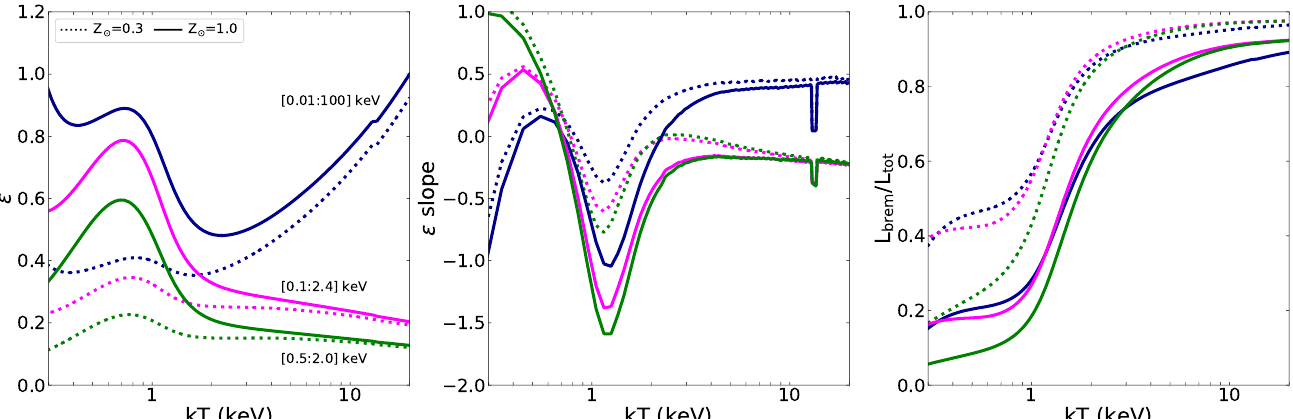
Figure 1. ( left panel ): total X-ray emissivity as function of the plasma temperature in different energy bands (bolometric in blue, 0.1–2.4 keV in magenta, and 0.5–2 keV in green). The curves are calculated using an APEC (Smith et al. [69]) model (v3.0.9) in XSPEC (Arnaud [70]) for two different values of metallicity: 1.0 (solid lines) and 0.3 times the solar abundance as in Asplund et al. [71]. All curves are normalized to the bolometric emissivity at k B T x = 20 keV with Z = 1Z (cid:12) . ( middle panel ): the emissivity slope as a function of temperature showing the impact of the different Z (cid:12) and T x in the low-temperature regime. ( right panel ): bremsstrahlung emission fraction (L brem /L tot ) as a function of the temperature, illustrating the increasing contribution of line emission to the total luminosity for low-temperature